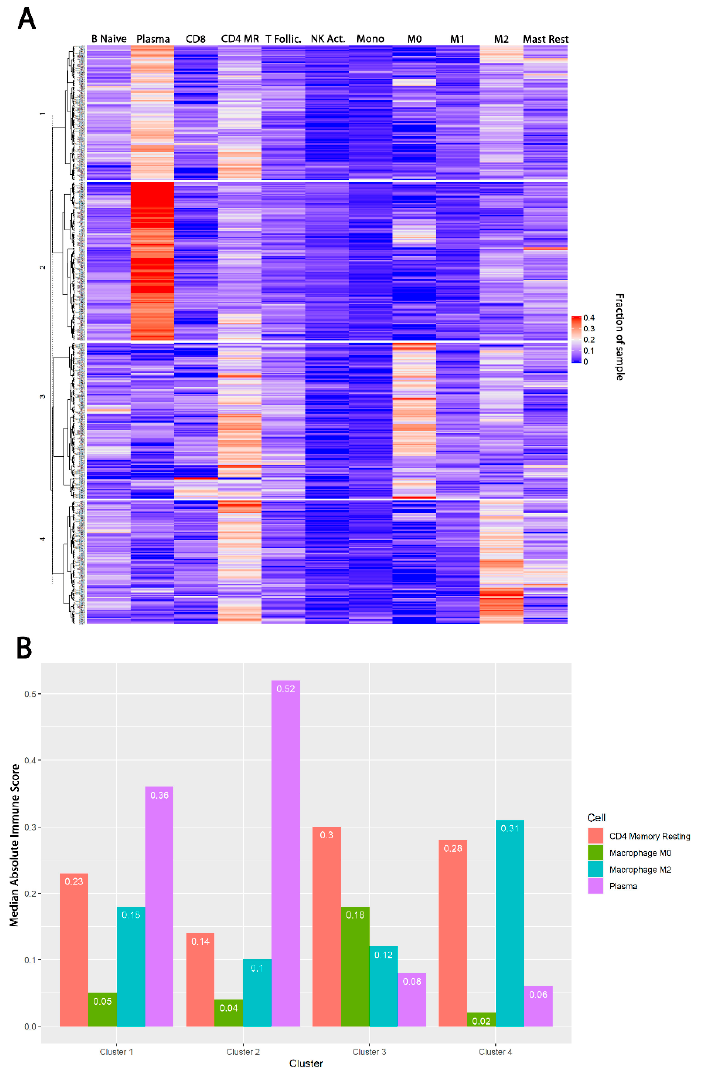
adenocarcinoma) TCGA dataset. The columns display the individual immune cells represented in each column, while the rows display the unique identifiers within each cluster. CD4 MR represents CD4 Memory Resting T cells. Cluster 1 is CD4 MR High Plasma Cell High M0 Low M2 Mid . Cluster 2 is CD4 MR Low Plasma Cell High M0 Low M2 Low . Cluster 3 is CD4 MR High Plasma Cell Low M0 High M2 Low . Cluster 4 is CD4 MR High Plasma Cell Low M0 Low M2 High . Panel ( B ) displays the median cell infiltration, derived from CIBERSORT absolute immune fraction, for the most prominent cell types in the TCGA PRAD database by cluster. Abbreviations: T follic, T follicular helper T cells; NK Act, activated natural